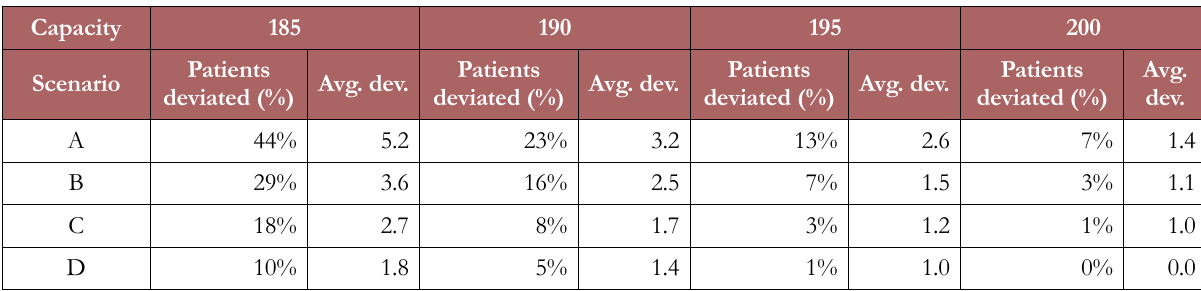
Table 9. Deviation from treatment plans for on-treatment